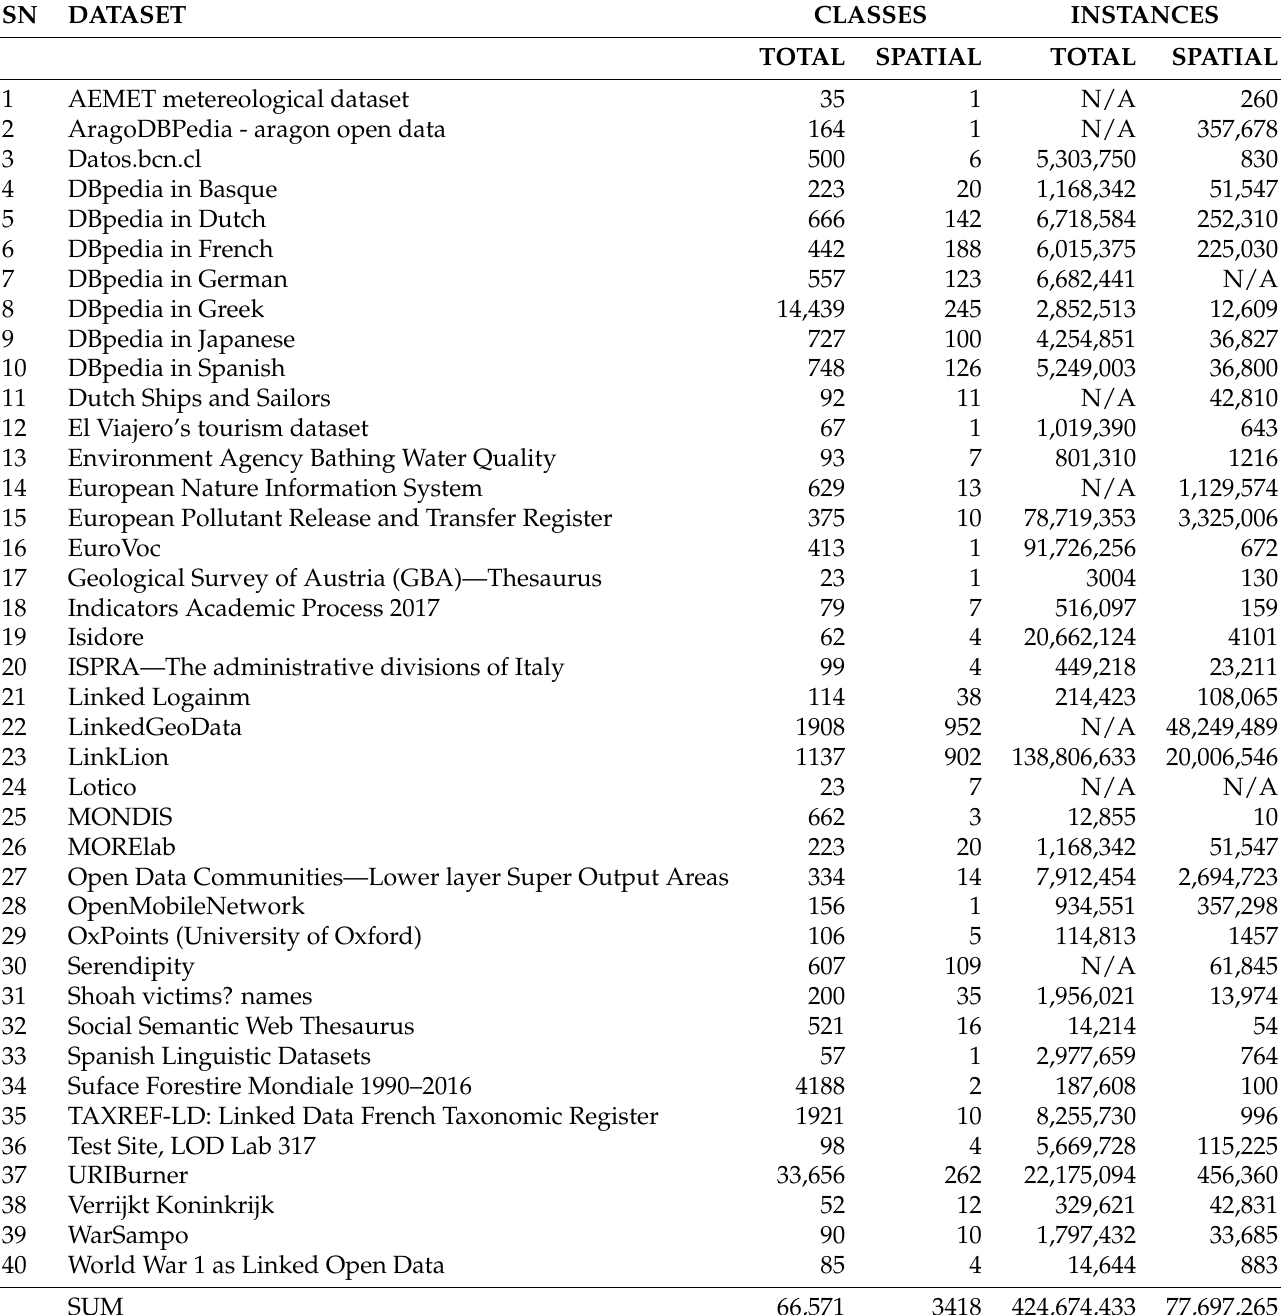
Table 3. Number of total and spatial classes, total and spatial instances for 40 SPARQL endpoints. N/A denotes that the number could not be retrieved because of errors returned from the endpoint.